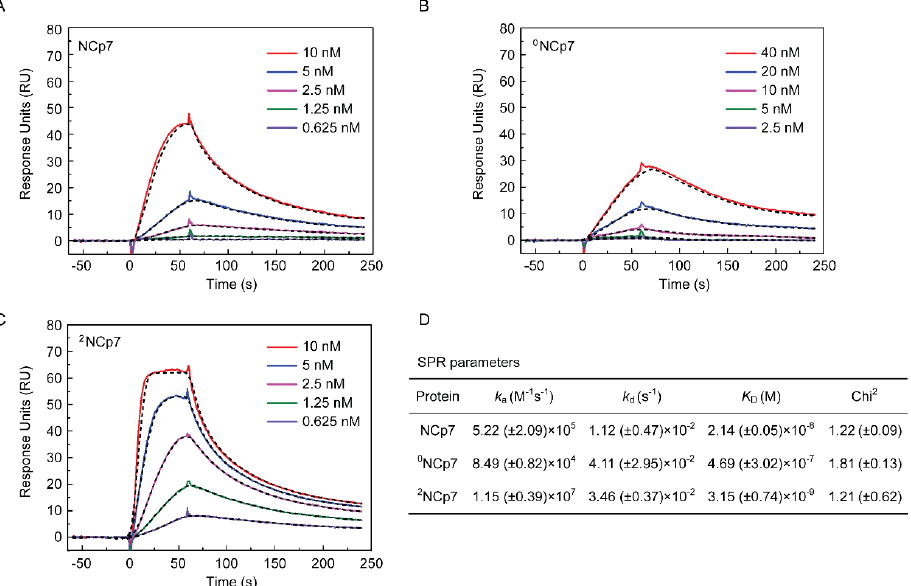
Figure 3. Kinetic analyses of 0 NCp7, NCp7 and 2 NCp7 binding to SL3-RNA, determined by SPR. Representative SPR kinetic curves and fits for ( A ) NCp7, ( B ) 0 NCp7 and ( C ) 2 NCp7 binding to SL3-RNA. The amount of SL3-RNA immobilized on the chip surface was 50 RU (A, C) and 100 RU (B), respectively. The concentrations of NCp7 and 2 NCp7 are 0.625, 1.25, 2.5, 5 and 10 nM, whereas the concentrations of 0 NCp7 are 2.5, 5, 10, 20 and 40 nM. Experimental and fitted curves are colored and black, respectively. ( D ) SPR parameters of 0 NCp7, NCp7 and 2 NCp7 binding to SL3-RNA, generated from two independent experiments, with standard deviations in brackets. Chi-square values are also shown, which describe the deviation between the experimental and fitted curves.